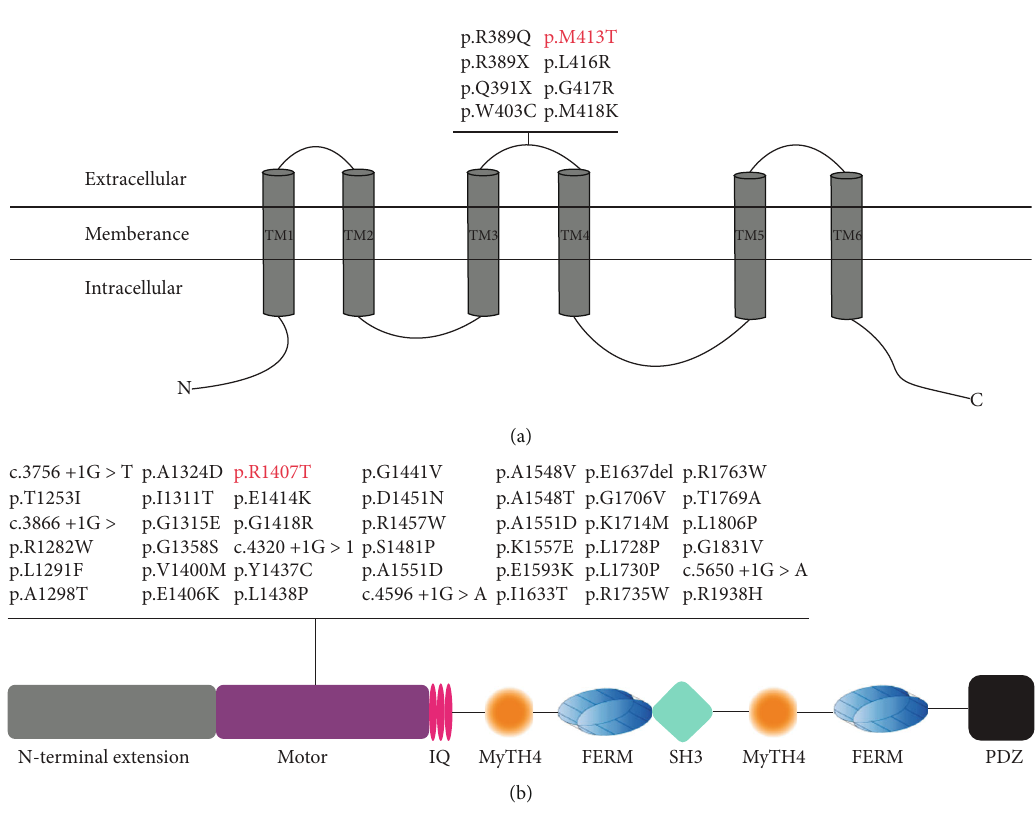
Figure 5: (a) Transmembrane domain structure of TMC1 and mutations in the second extracellular loop of TMC1 . The novel p.M413T mutation identi fi ed in this study is in red. (b) Protein structure of Myosin XVA and missense mutations in the motor domain. The novel p.R1407T mutation identi fi ed in this study is in